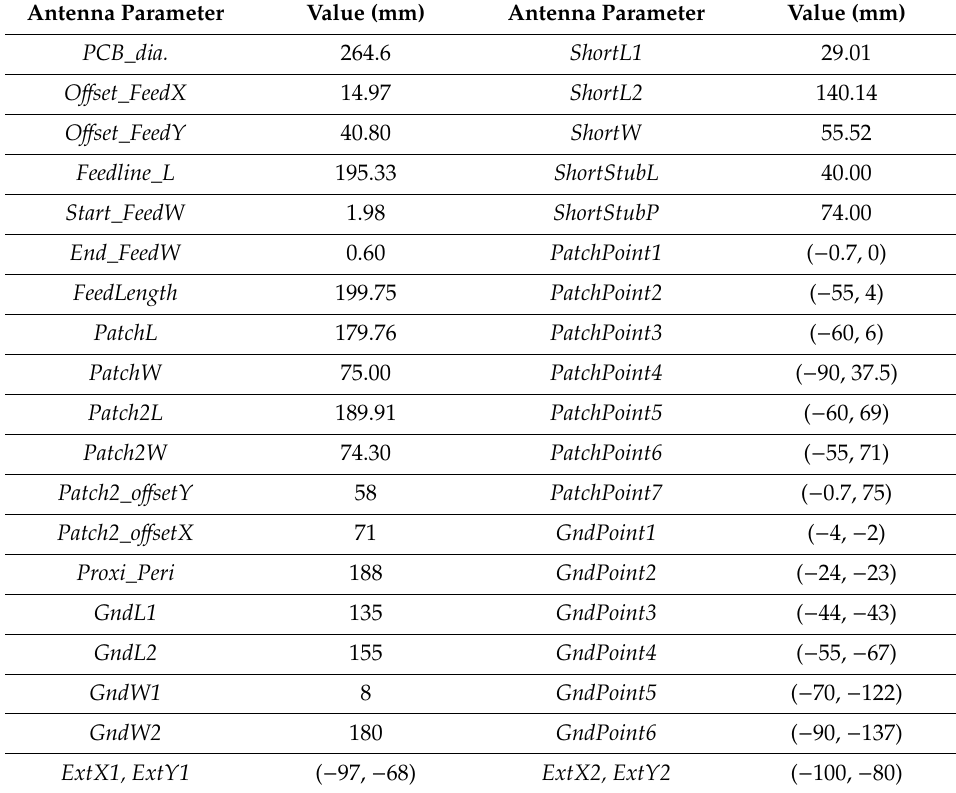
Table 4. Proposed antenna